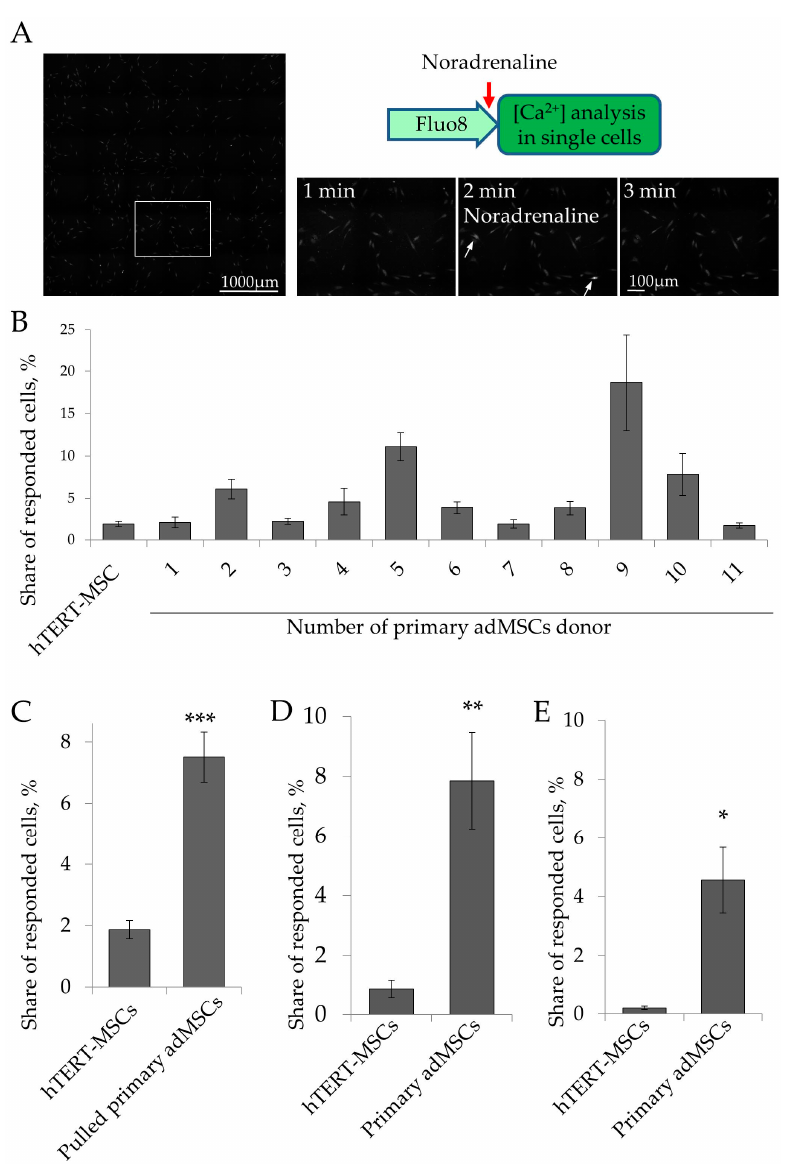
Figure 3. hTERT-MSCs demonstrated impaired sensitivity to noradrenaline. ( A ) Scheme of experiment and representative images of Ca 2+ registration in single cells using Fluo-8 dye. Large field of view and 100–200 cells were analyzed simultaneously. ( B ) Share of hTERT-MSCs and primary adMSCs, derived from different donors and that responded to noradrenaline applications by Ca 2+ release. ( C ) Share of pulled sample of primary adMSCs that responded to noradrenaline applications by Ca 2+ release compared to hTERT-MSCs. ( D ) Share of hTERT-MSCs and primary adMSCs that responded to α 1-agonist phenylephrine (10 − 4 M) applications by Ca 2+ release. ( E ) Share of hTERT- MSCs and primary adMSCs that responded to α 2-agonist clonidine (10 − 4 M) applications by Ca 2+ release. Mean ± SEM, comparison was performed by Mann–Whitney U-criteria (M-U test) because of